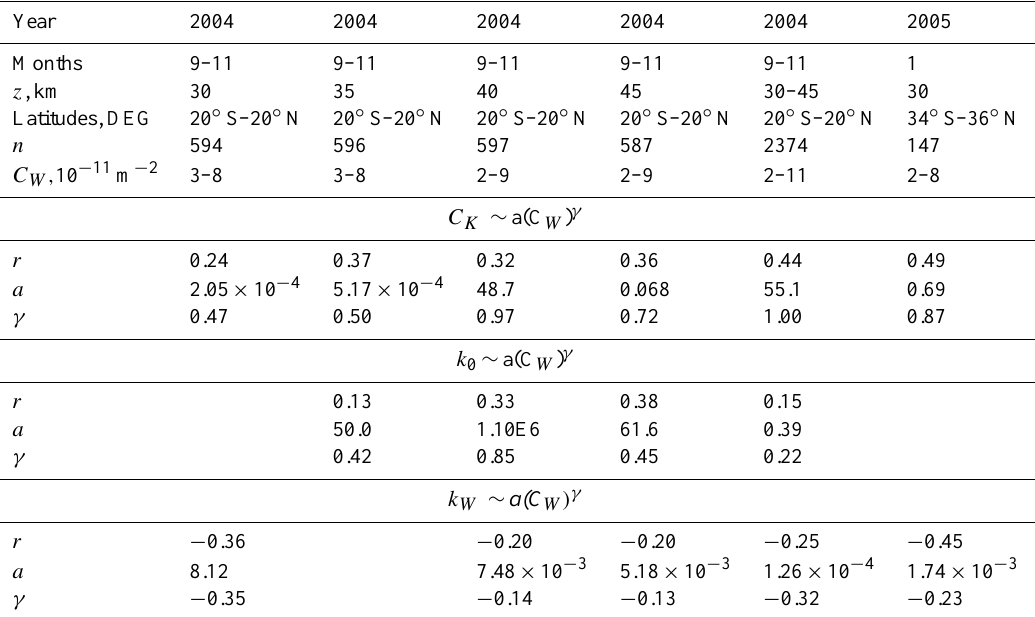
Table 2. Cross-correlation coefficients and parameters of power dependences between parameters of anisotropic and isotropic components of atmospheric perturbation